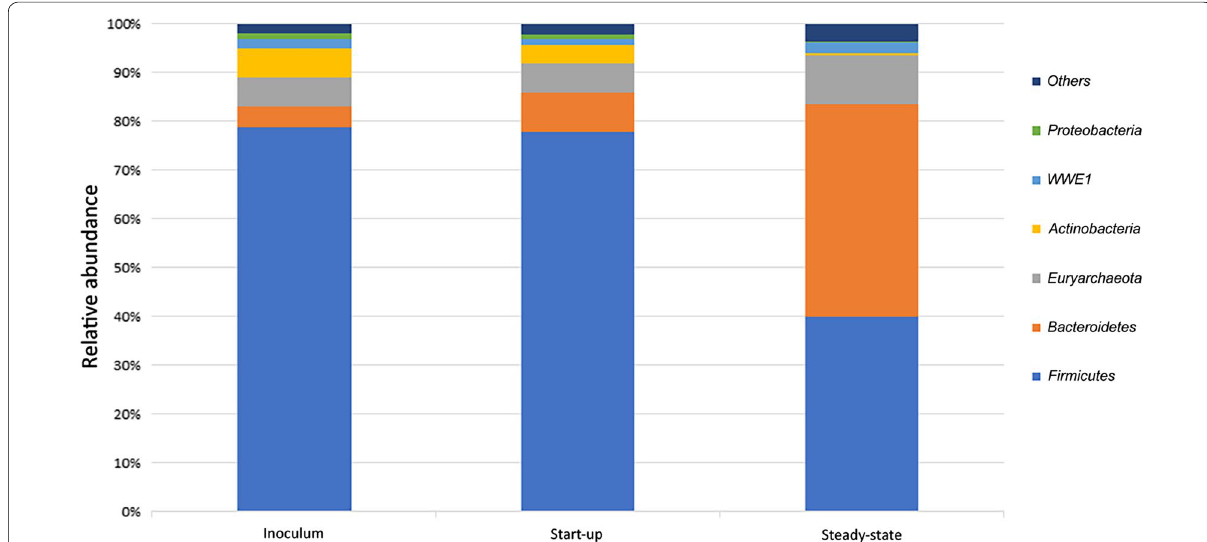
Fig. 2 Taxonomy bar-plot shows the relative abundance of OTUs at the phylum level. Different OTU abundances are shown in the inoculum and in the reactor digestate, during start-up and steady-state